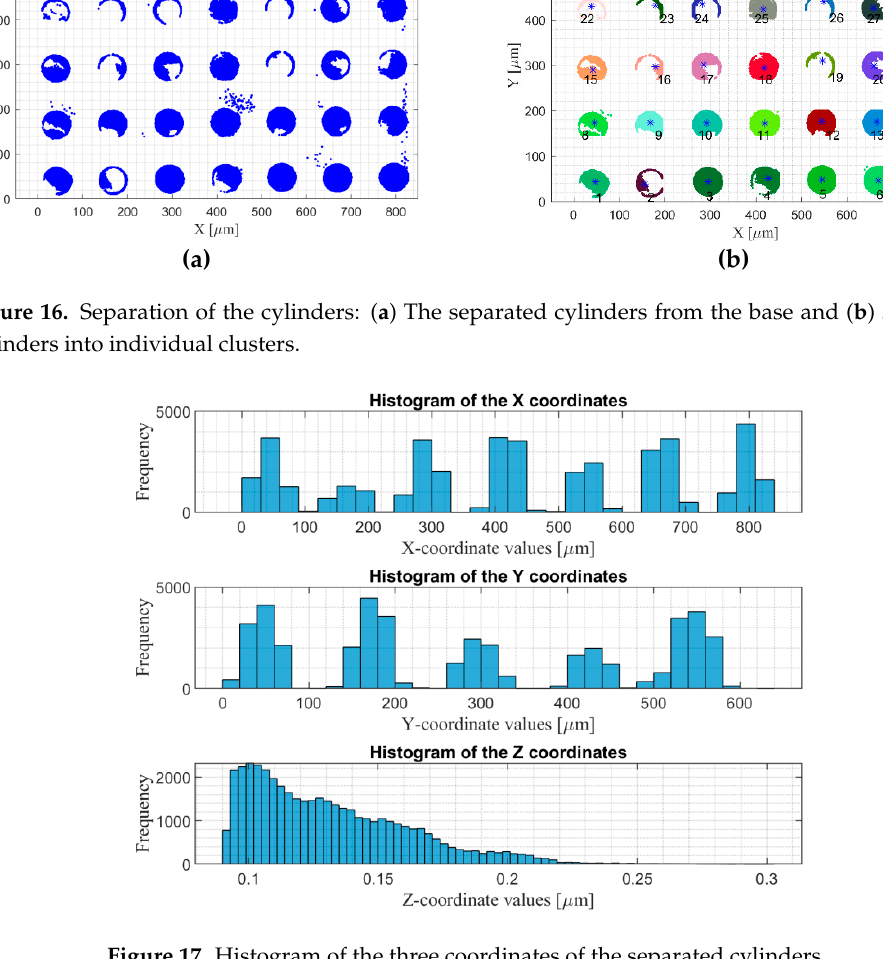
Figure 17. Histogram of the three coordinates of the separated cylinders.